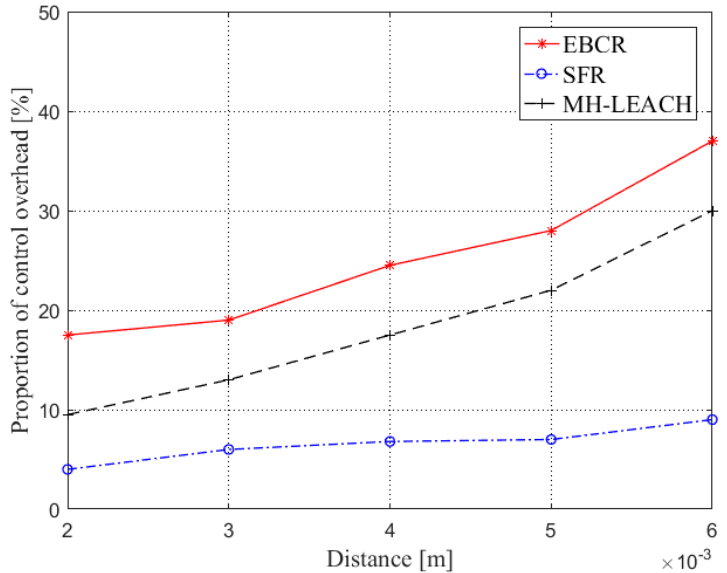
Figure 14. Comparison of proportion of control overhead.